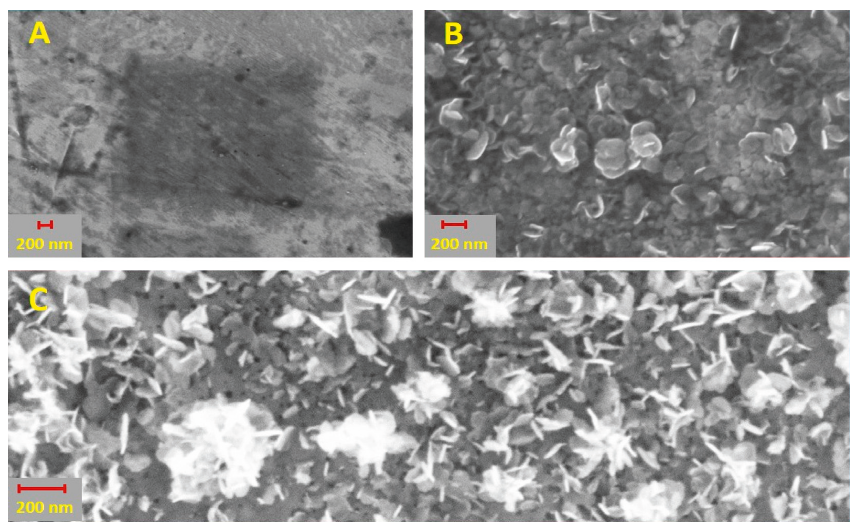
Figure 2: FE-SEM images of the bare Pt (A), FeOx/Pt (B), and a-FeOx/Pt ( − 0.5V) (C)